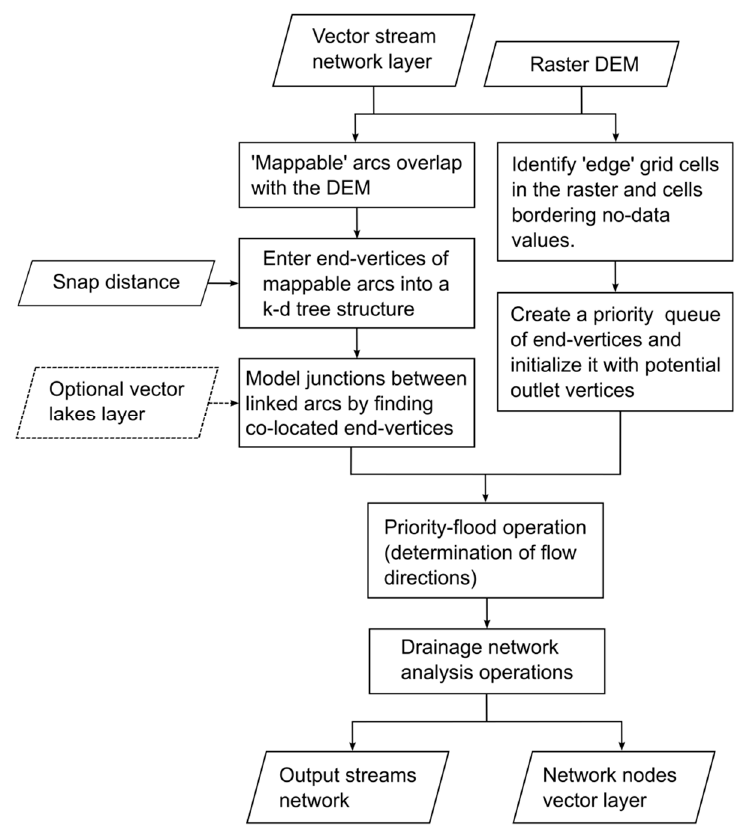
Figure 1. The priority-flood based vector drainage network analysis algorithm.